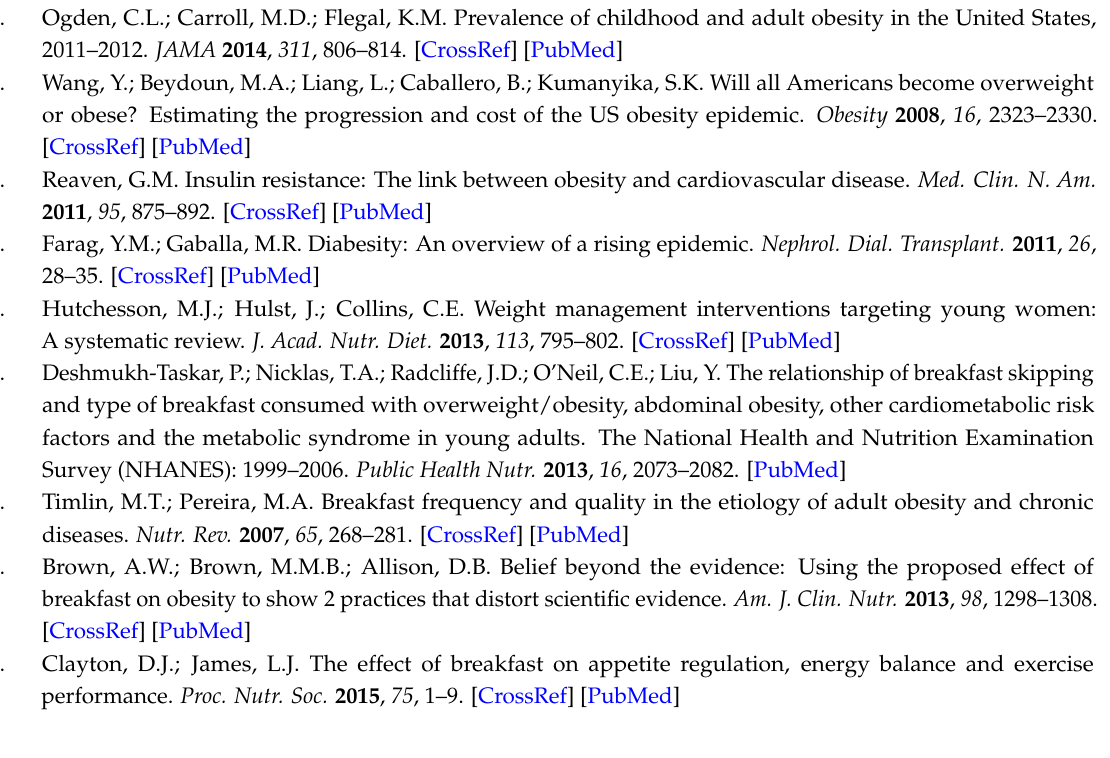
Figure S1: Resting energy expenditure (REE) at baseline. There was no significant difference in REE between dietary treatments or day 1 and 8 of the intervention period, Table S1: Brands of foods used in the dietary intervention, Table S2: BMI, Height and Weight of Participants on D1 and D8, Table S3: Postprandial metabolic variables following consumption of either CHO- or PRO- based test